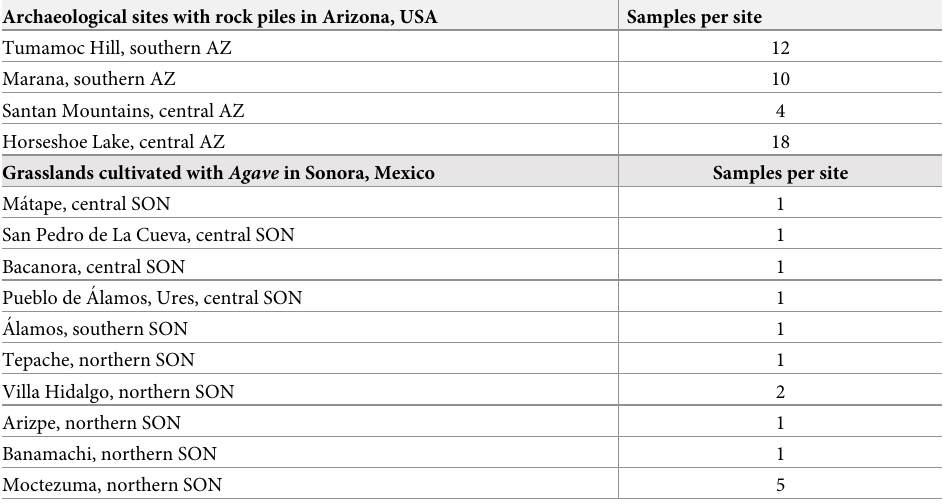
Table 1. Sites and numbers of samples evaluated in our study of rock piles (top portion of table) and grasslands cultivated with Agave angustifolia (bottom portion of table) using MaxEnt. Archaeological sites with rock piles in Arizona,